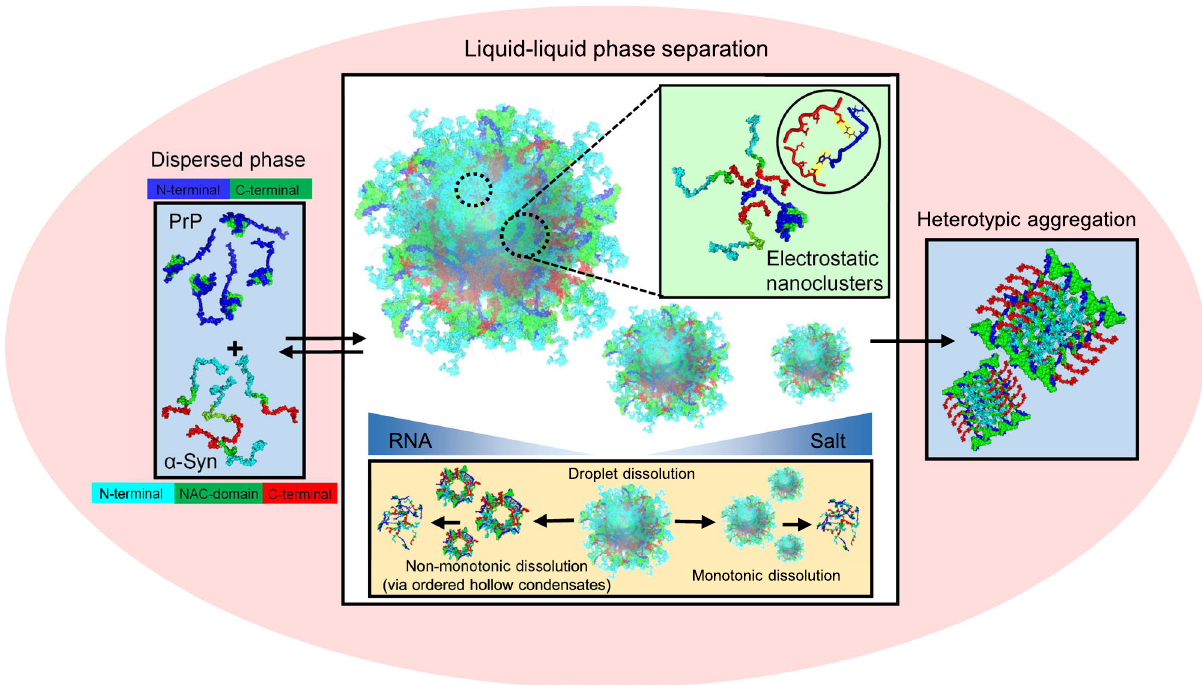
Fig. 6 A schematic of PrP- α -Syn-RNA multicomponent condensates. Complex coacervation of PrP and α -Syn drives the formation of partially ordered transient electrostatic nanoclusters. The addition of salt results in a monotonic condensate dissolution, whereas, the addition of RNA results in a non- monotonic dissolution via multiphasic hollow condensates. PrP- α -Syn condensates undergo a liquid-to-solid transition into heterotypic